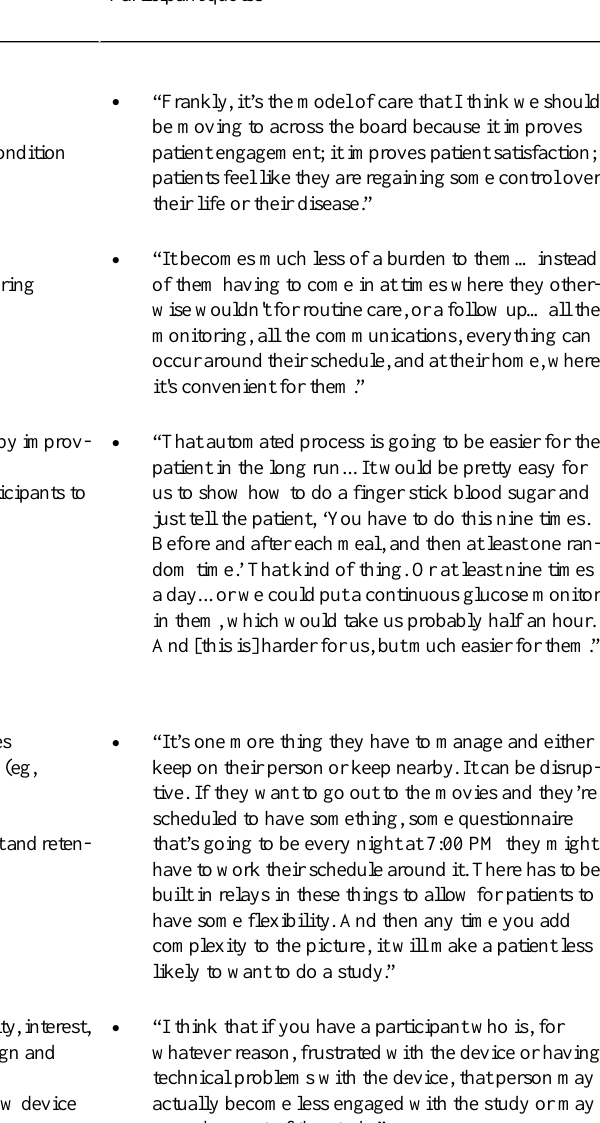
Participant quotesParticipant examples and descriptionsAdvantages and